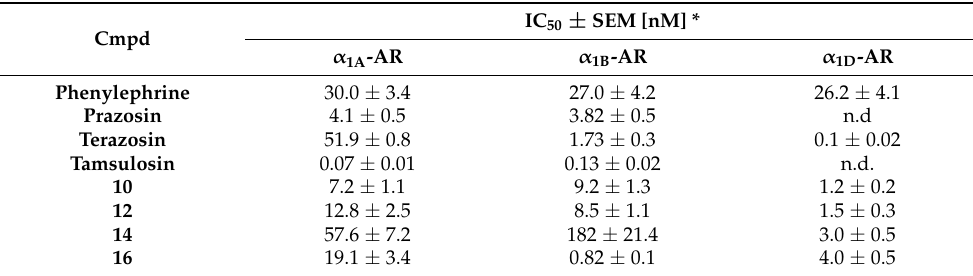
Table 2. Functional activity results of reference and tested compounds 10 , 12 , 14 and 16 at α 1A -AR in rat tail artery, at α 1B -AR in mouse spleen and at α 1D -AR in rat aorta.